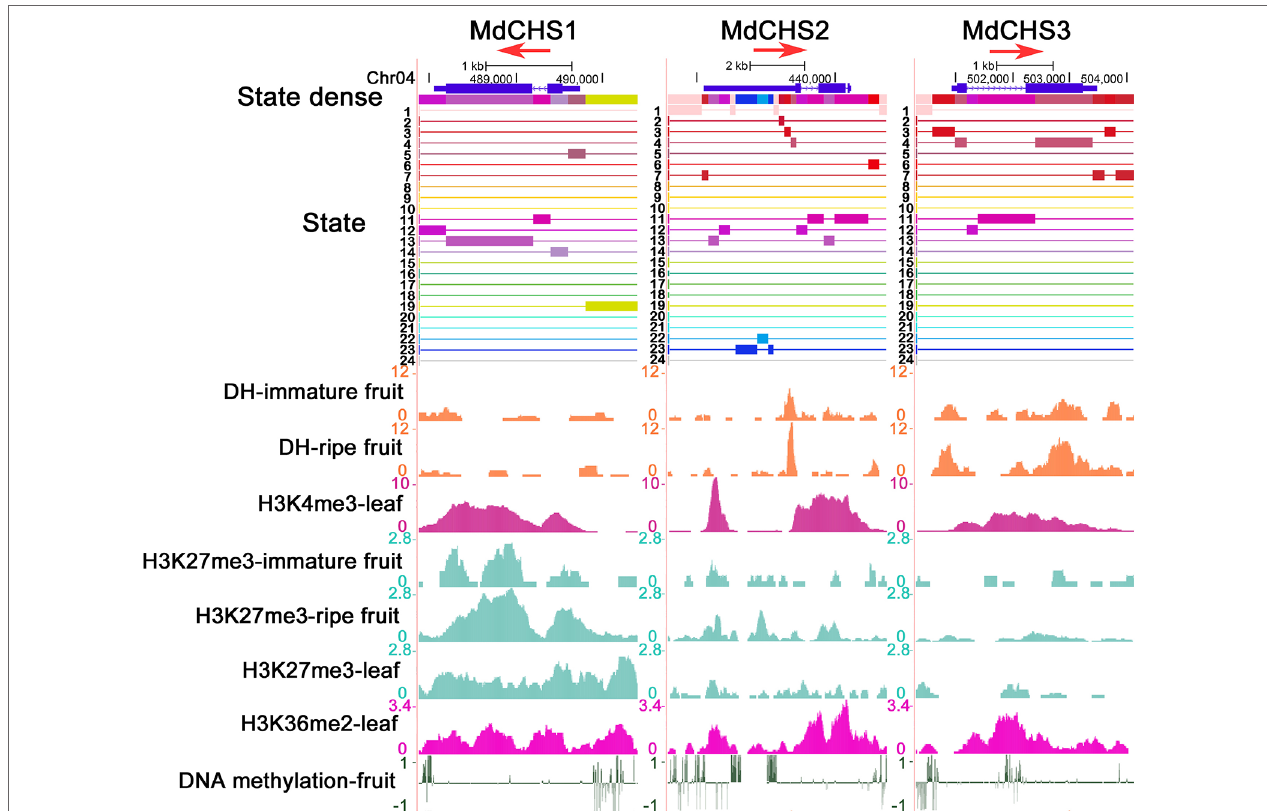
FIGURE 4 | Chromatin state analysis of three MdCHS genes. Associated states and epigenetic marks of MdCHS1 , MdCHS2 , and MdCHS3 in the UCSC genome browser. The red arrow represents the direction of gene